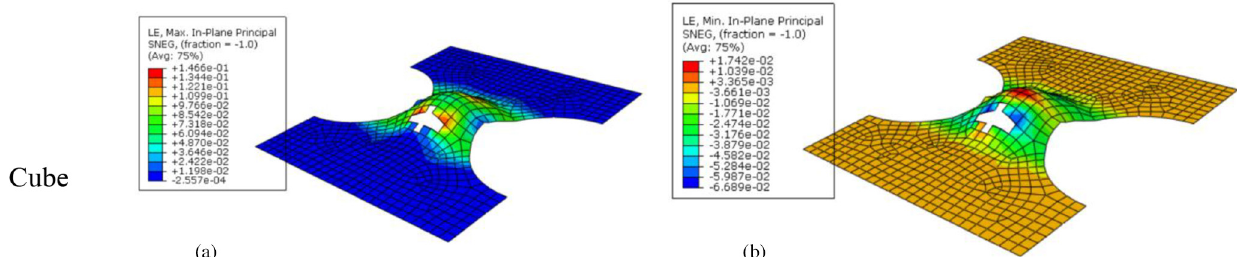
Fig. 8. (a) Maximum in-plane principle strain under plane stretching. (b) Minimum in-plane principle strain under plane stretching.